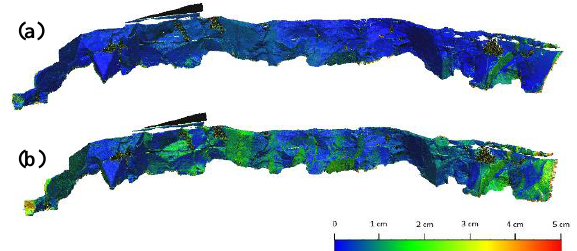
Figure 5. Error mapping of the deviation between: (a) TSL and model P3-PS-Target and (b) TSL and model P3-PS-Natural